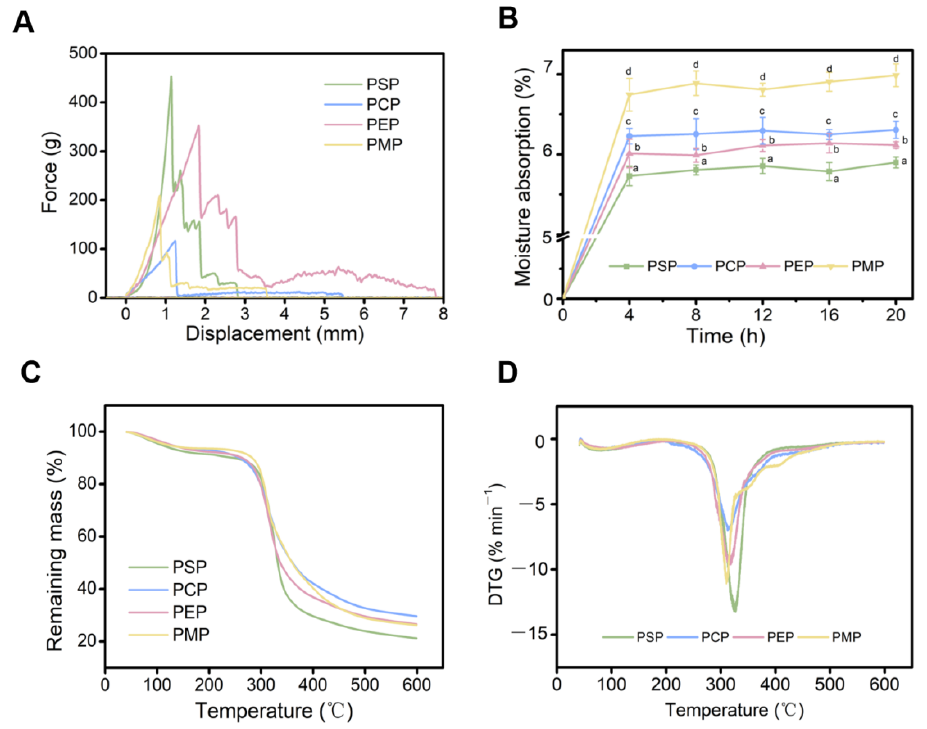
Figure 2. Physical properties of four P. eryngii papery food items. The force–displacement curves ( A ) and moisture absorption properties ( B ) of P. eryngii papery food. Thermogravimetric ( C ) and derivative thermogravimetric ( D ) curves of P. eryngii papery food. Values are expressed as mean ± standard deviation values. Different letters within the same column indicate significant differences ( p < 0.05).